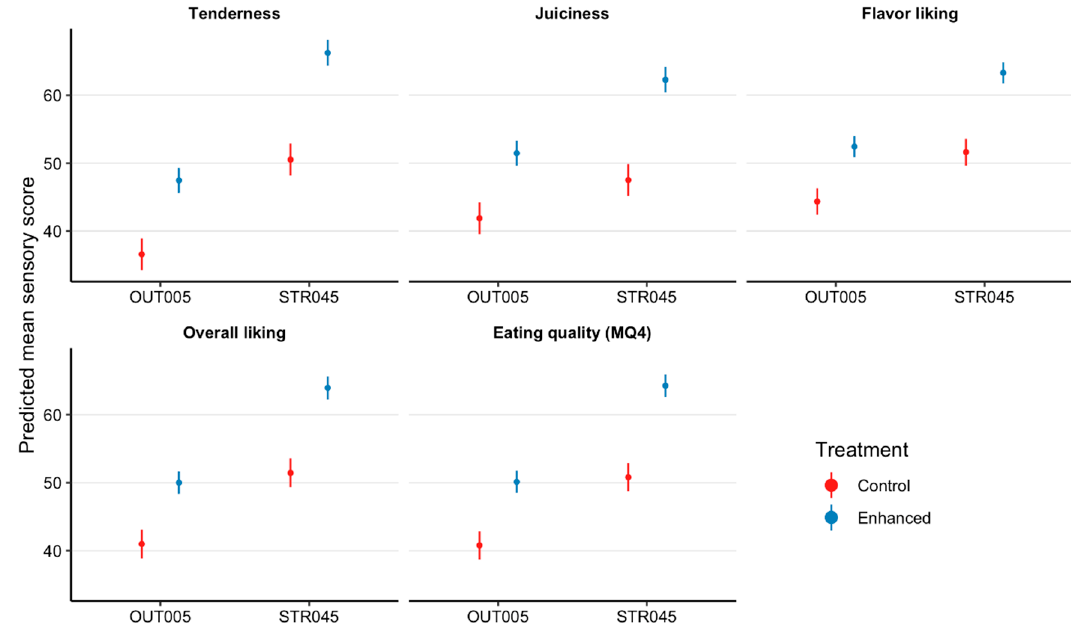
Figure 4. Estimated marginal means with 95% confidence intervals for tenderness, juiciness, flavor, overall liking, and eating quality (MQ4) scores of striploins (STR045, M. longissimus lumborum ) and outside flats (OUT005, M. biceps femoris ) presented to consumers ( n = 2080) that were not infused (control) and infused with a kiwifruit extract (enhanced).